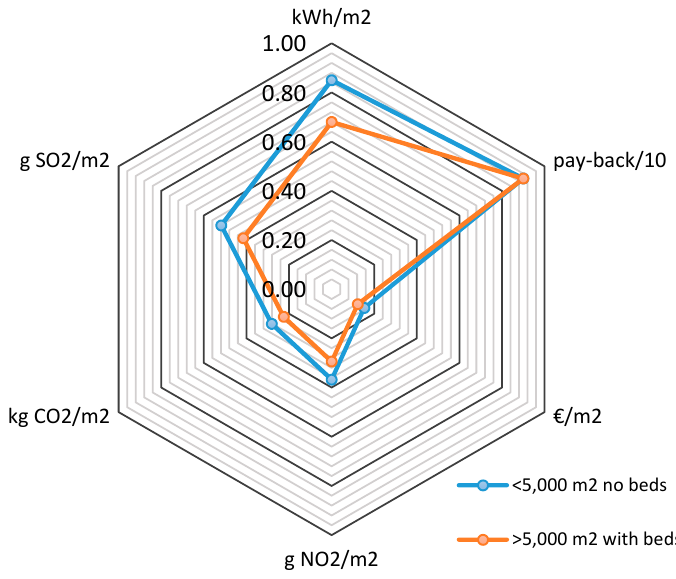
Figure 7. Potential of energy saving derived from thermal insulation improvement.